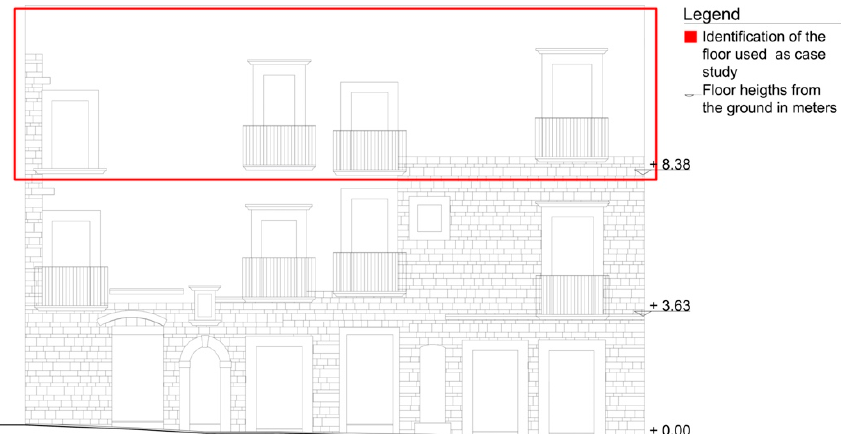
Figure 3. Main elevation of the selected building.